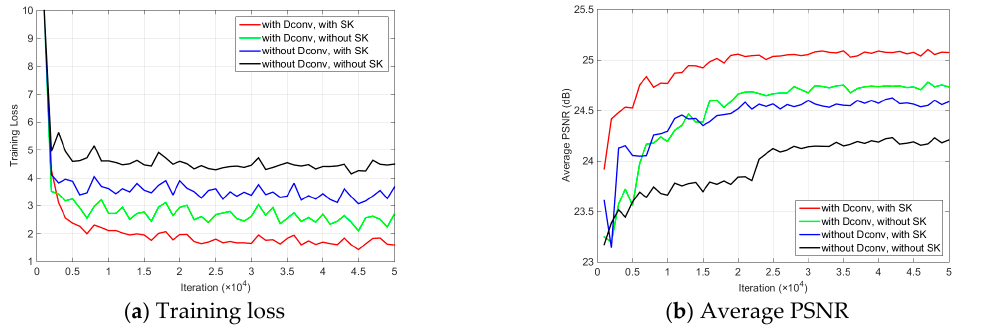
Figure 12. The simulated SAR image despeckling results of the four specific models in ( a ) training loss and ( b ) average PSNR, with respect to iterations. The four specific models were different combinations of dilated convolutions (Dconv) and skip connections (SK), and were trained with one-look images in the same environment. The results were evaluated for the Set14 [43] dataset.